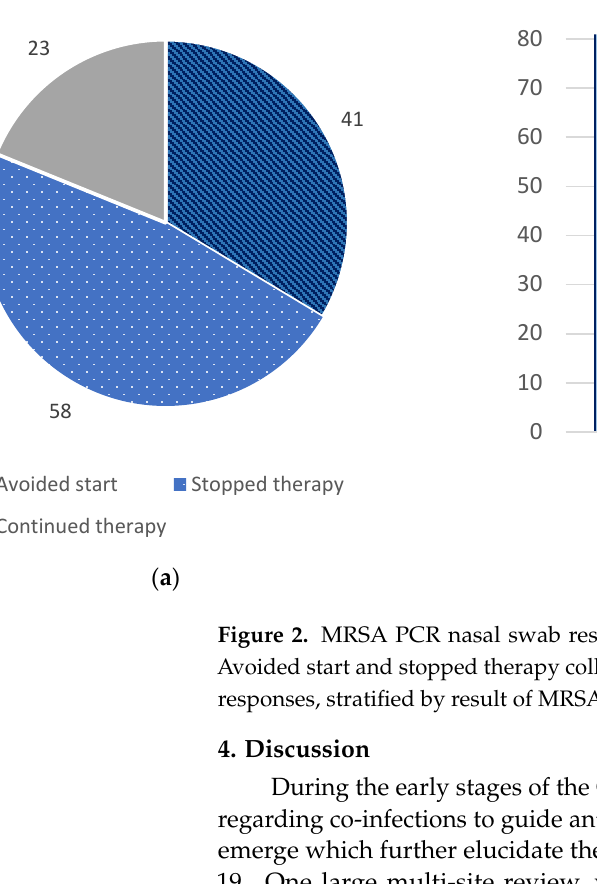
bacterial co-infection of 3.5% [14]. An observational cohort study identified a rate of 3.1% for community-acquired bacterial co-infections and 4.4% for hospital-acquired bacterial co-infections [15]. One large meta-analysis (including 75,956 evaluable patients)